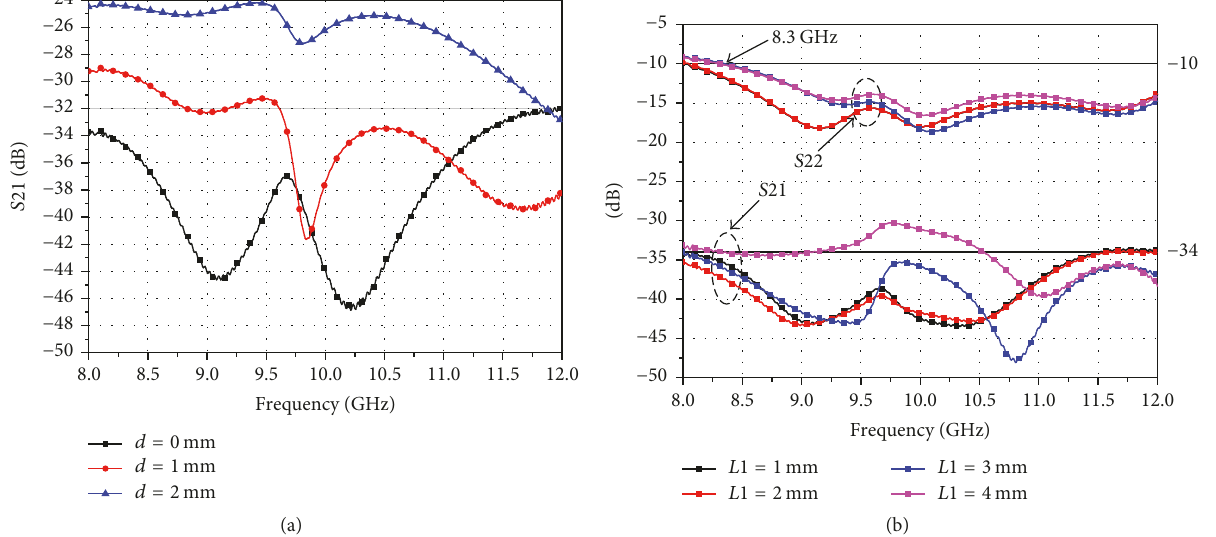
Figure 7: (a) Effect of the different 𝑑 on the isolation of two ports. (b) Simulated return loss of Vivaldi 2 and isolation with the different length of galvanic